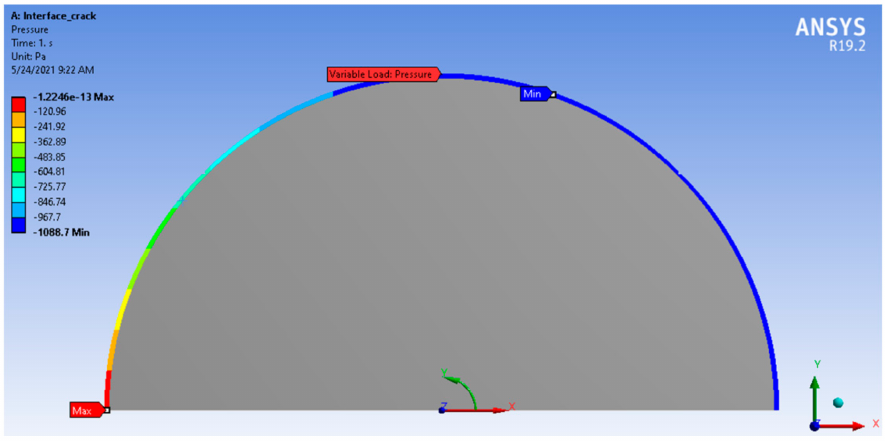
Figure 1. Variable shear load on arc